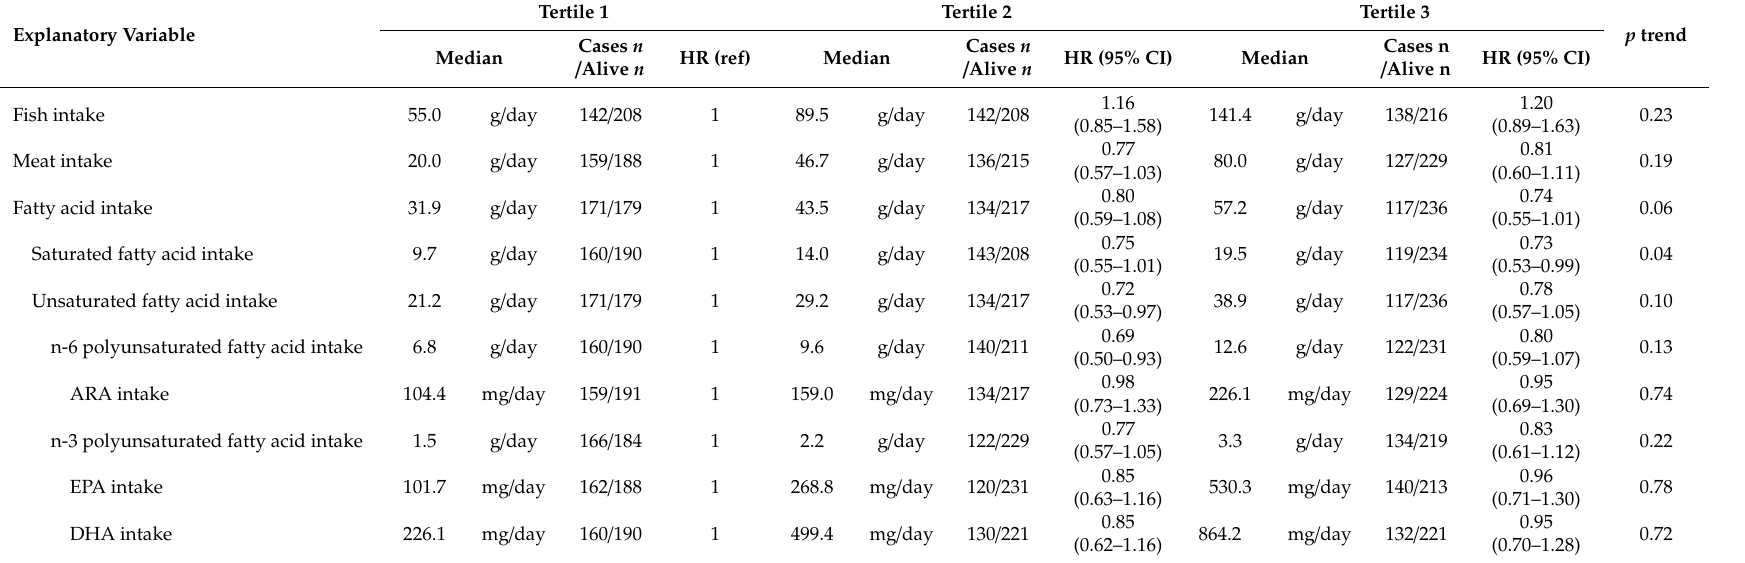
Table 2. Multivariate-adjusted hazard ratios 1 for all-cause mortality of fish, meat, and fatty acid intakes ( n = 1054). Explanatory